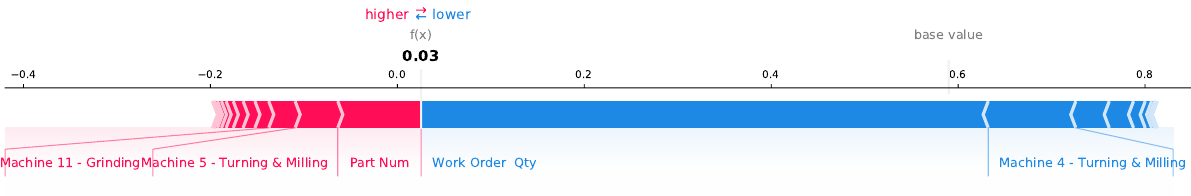
Figure 15. SHAP values of cable